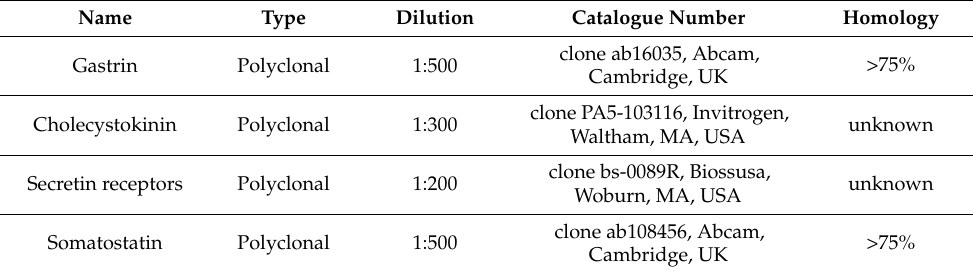
Table 1. Specification of the primary antibodies